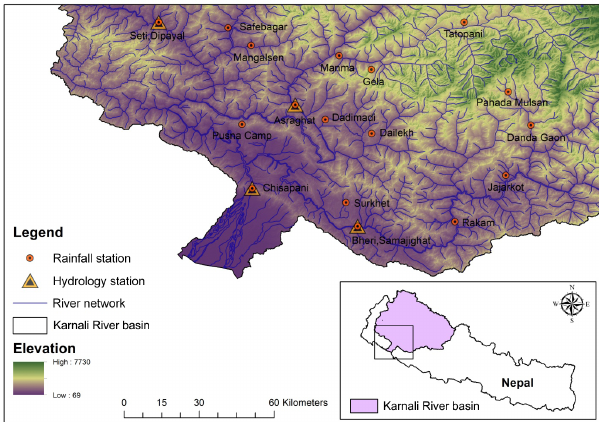
Figure 2. Detailed map of the Karnali River basin, including to- pographic detail and the location of monitoring stations within the